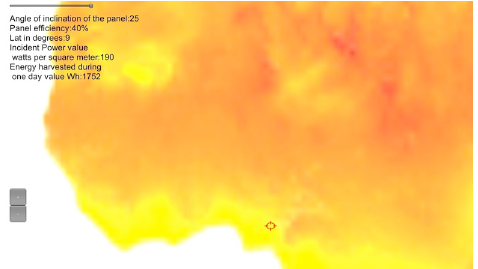
Figure 5. Example of augmented virtuality solar energy calculator in